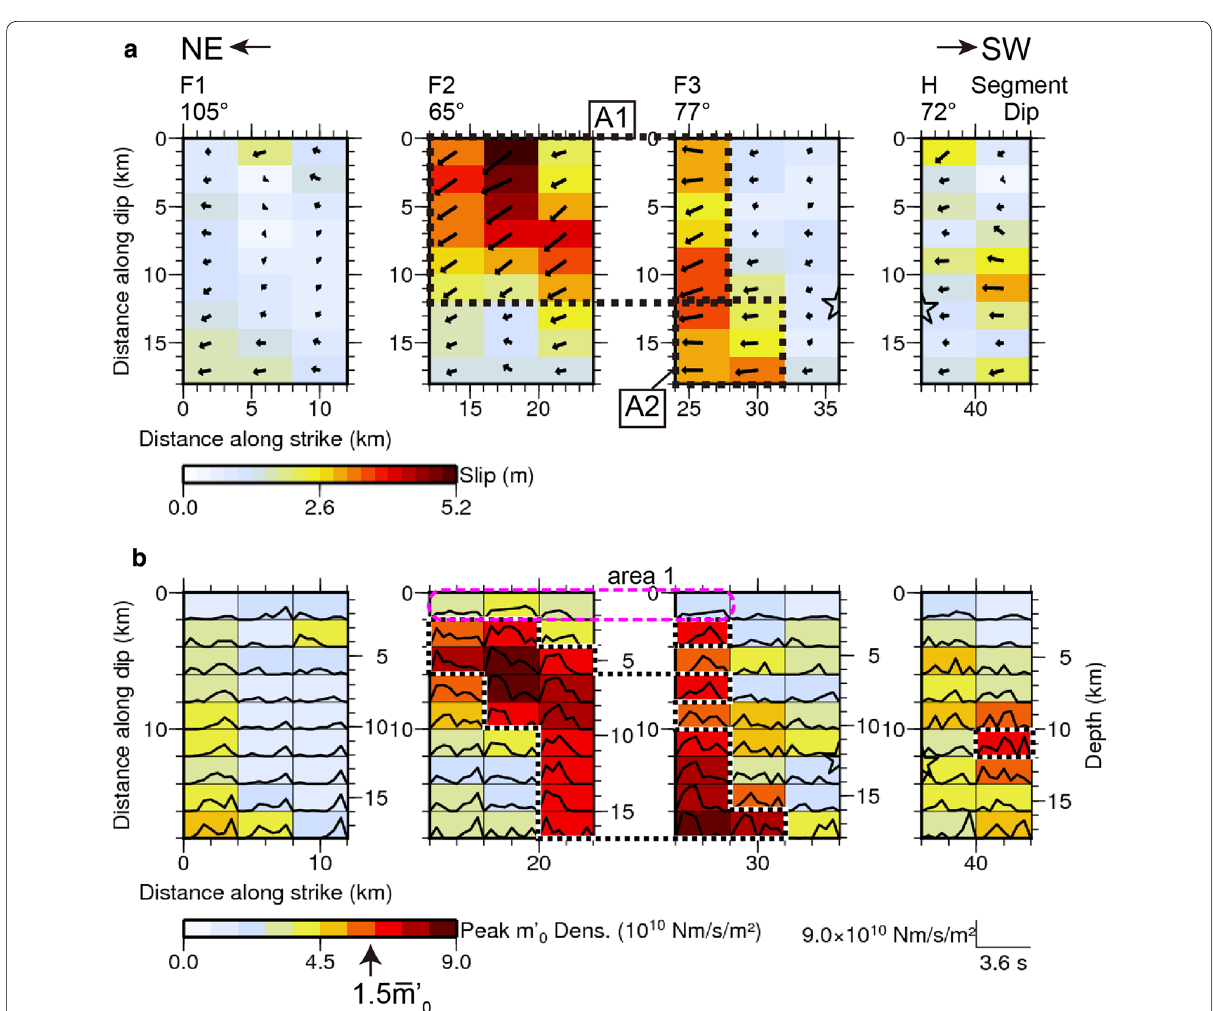
Fig. 5 Result of second-step inversion that was using 0.05–1.0 Hz band-pass strong-motion data. a Total slip distribution. Dotted rectangles indicate the asperities following the criterion by Somerville et al. (1999). b Moment rate ( m ′ 0 ) functions. Backgrounds indicate peak rate of the moment rate functions. Fault elements with of moment rate peaks at least 1.5 times larger than the average over the fault ( ¯ m ′ 0 ) are enclosed by dotted lines . Area 1 is enclosed by the purple dashed line